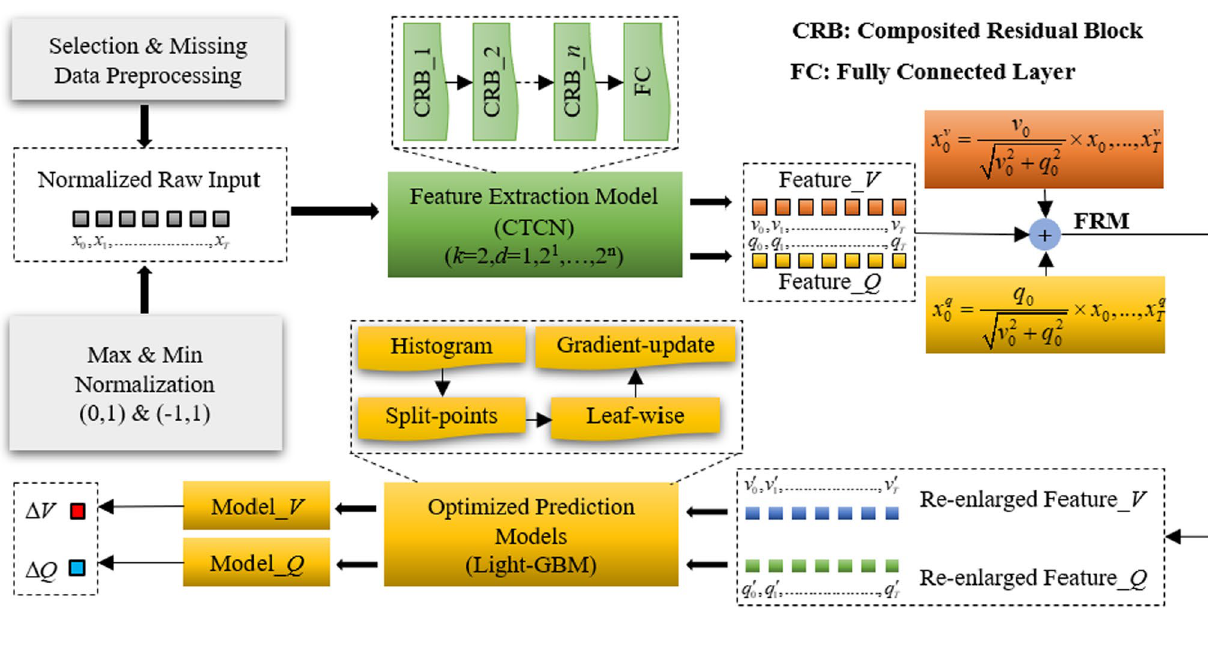
Fig. 2 The detailed process of the proposed CTCN-LightGBM Table 1 The raw dataset processing methods